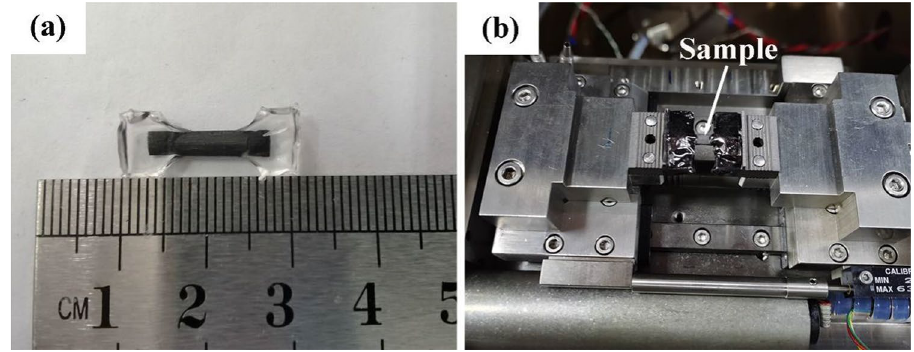
Figure 3. In-situ tensile SEM observation of SiC f /SiC minicomposite: ( a ) sample and ( b ) tensile platform.